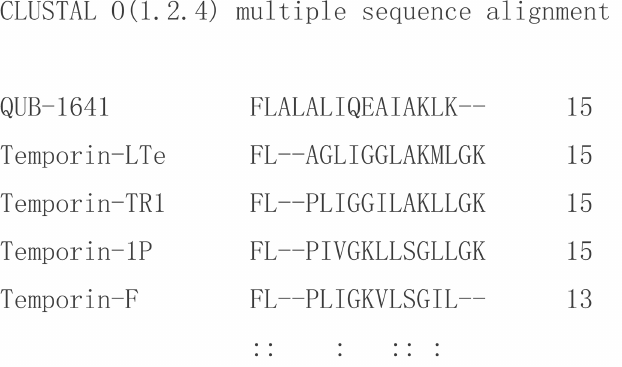
Figure 4. The sequences of kassporin-KS1 (QUB-1641) and some partially similar temporins were compared using Clustal Omega. The colons indicate similar residues.